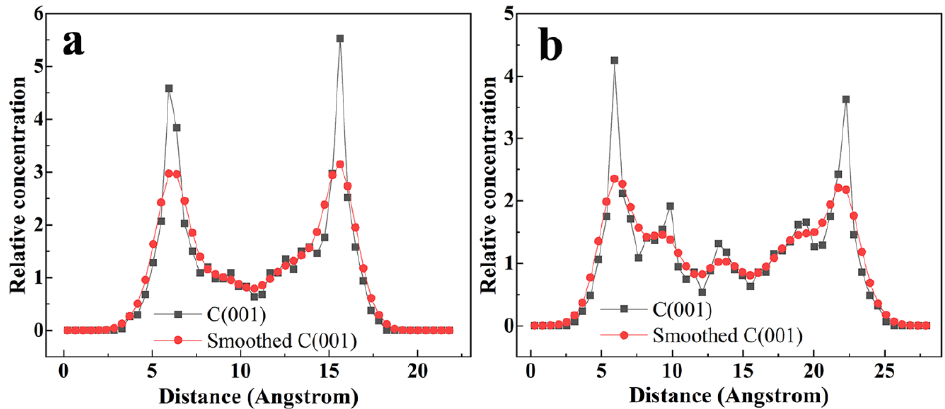
Figure 13. Distribution of relative concentration in the axial direction ( a ) UCAC cm ( b ) UCAC new.